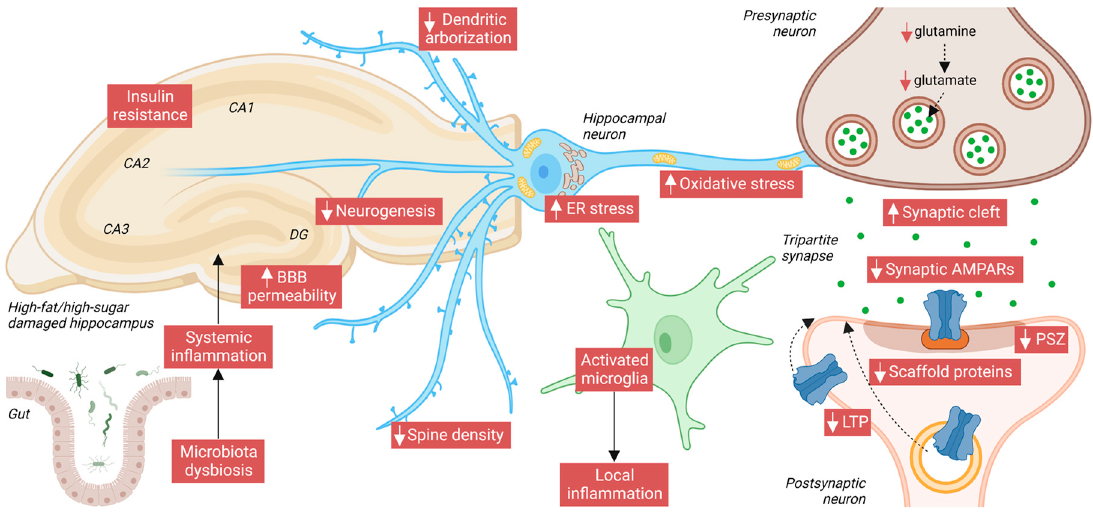
Figure 3. Main hallmarks of HFD/high-sugar-(HSD)-mediated HPC damage. At the systemic level, both fat and sugar produce gut microbiota dysbiosis, which can exacerbate inflammation in the brain by enhancing blood-brain barrier (BBB) permeability. BBB damage, in turn, contributes to deregulating the transport of circulating orexigenic and anorexigenic hormones. In the HPC, local release of neuroinflammatory factors by activated microglia exacerbates neuronal damage. INS resistance, increased endoplasmic reticulum (ER), and oxidative stress also compromise neuronal function. In HPC neurons, HFD/HSD intake reduces dendritic arborization, spine density, and the PSZ, and widens the synaptic cleft. The glutamate neurotransmitter and its precursor, glutamine, are reduced, and also reduced over the short/medium-term are levels of AMPARs and of its scaffold protein PSD95. Finally, impaired activity-dependent synaptic plasticity (especially LTP) proves that AMPAR trafficking to the PM is also compromised by an HFD/HSD. Image created with